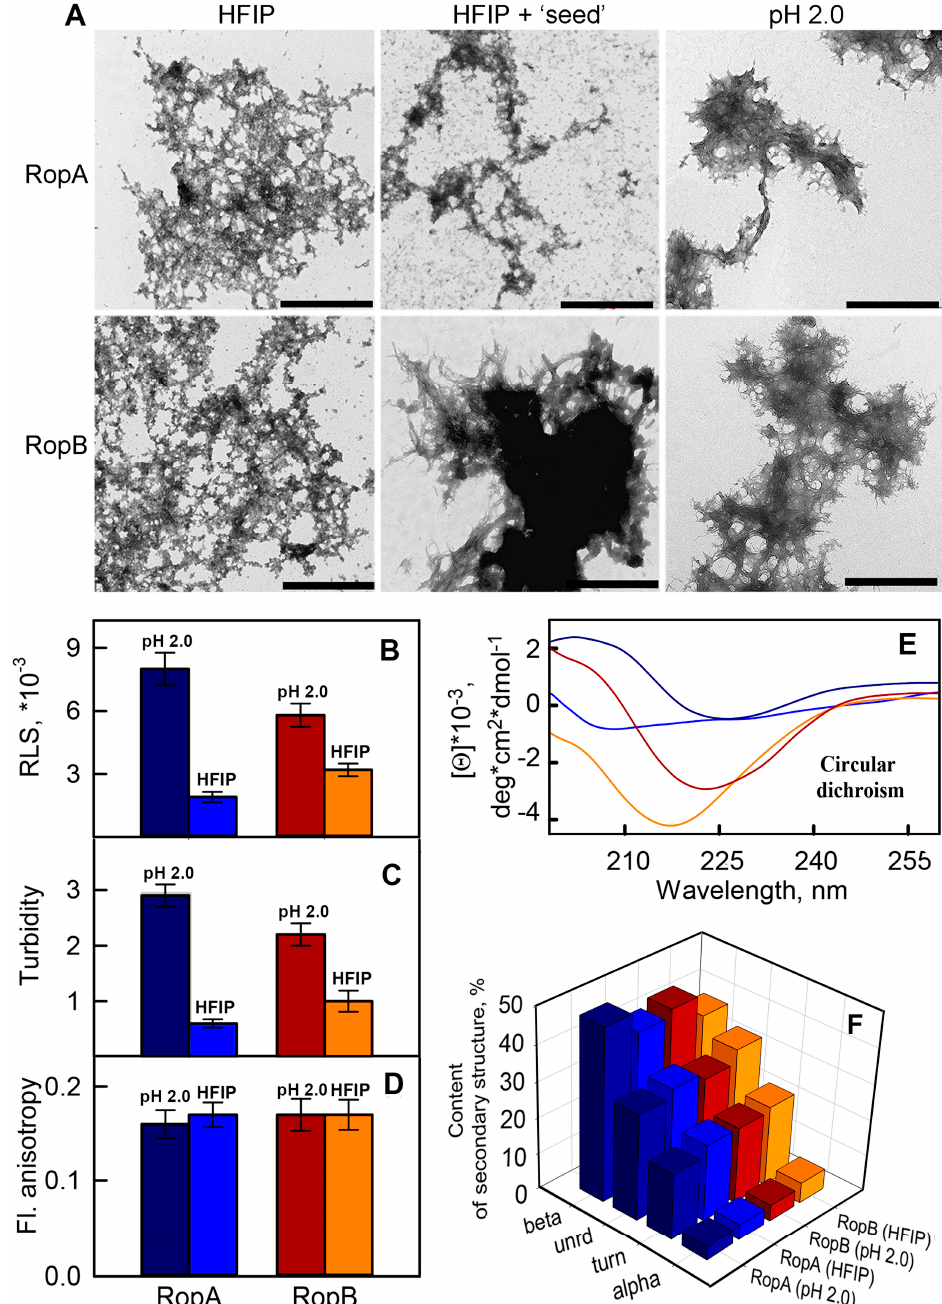
Figure 2. RopA and RopB form morphologically and structurally distinct aggregates in different conditions. ( A ) TEM images of RopA (top panels) and RopB (bottom panels) aggregates, obtained in various conditions: using an organic solvent 1,1,1,3,3,3-hexafluoro-2-propanol (HFIP) without (left panels) and with (middle panels) “seeding” and using a buffer with acidic pH 2.0 (right panels). The scale bar on the electron microscopy images is equal to 1 µm. ( B ) Rayleigh light scattering (RLS), ( C ) turbidity, ( D ) fluorescence anisotropy, and ( E ) circular dichroism (CD) of amyloids. ( F ) Content of elements of the secondary structure in aggregates: beta-sheets (beta), unordered structure (unrd), turns (turn), and alpha-helices (alpha). Spectra and bars colors of the panels ( B – F) denote characteristics of the RopA aggregates prepared at pH 2.0 (dark-blue color) or using HFIP without “seeding” (blue) and RopB aggregates prepared at pH 2.0 (dark-red color) and using HFIP without “seeding” (orange).